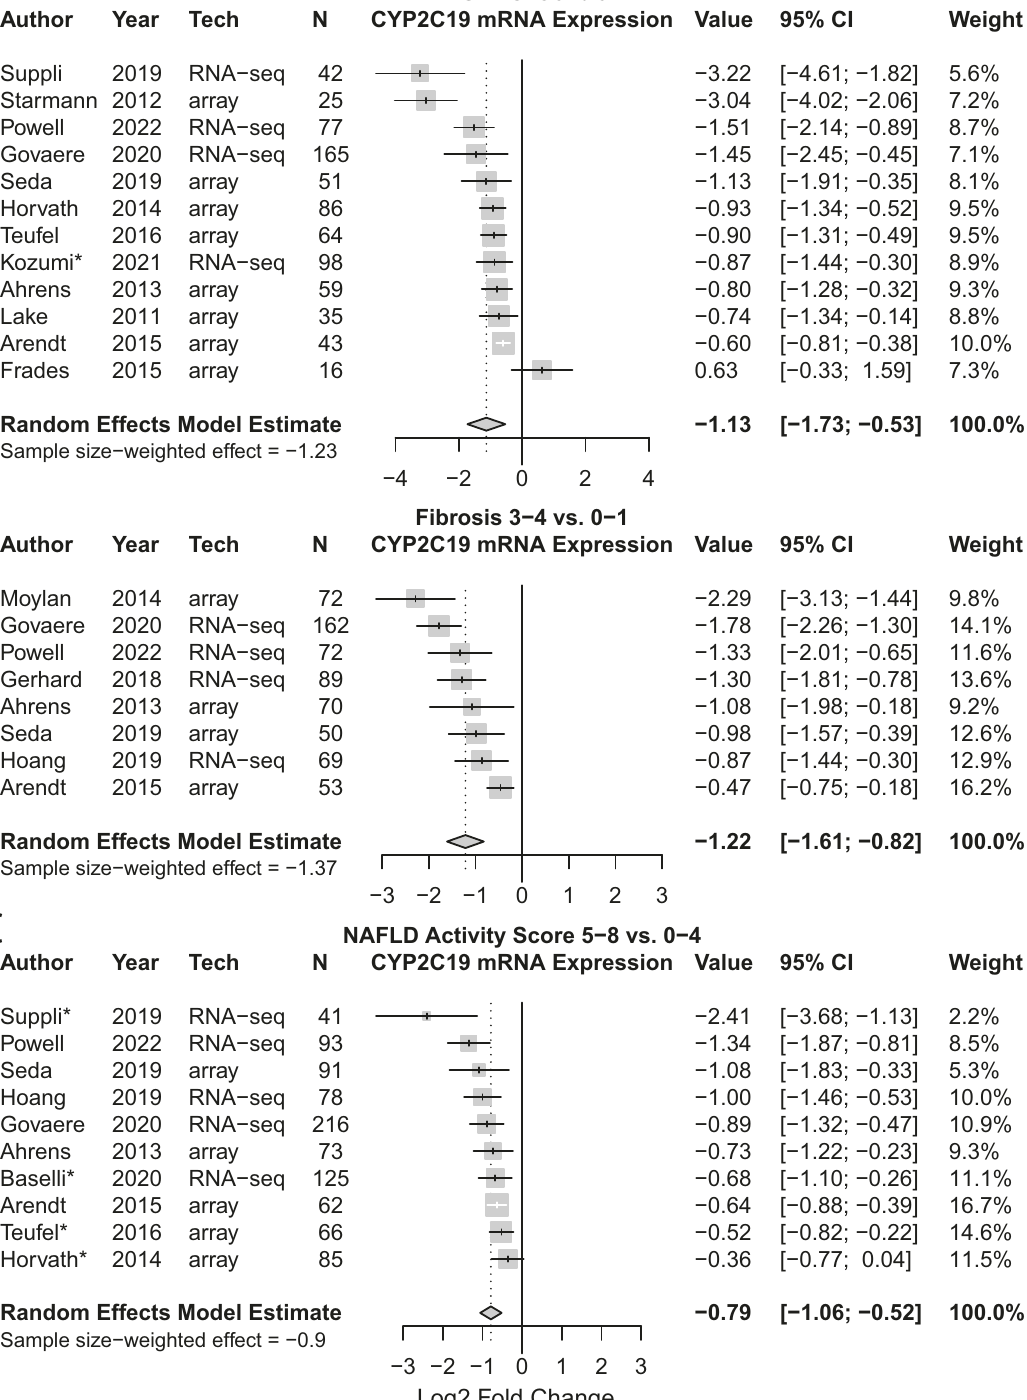
marked with an asterisk (*) NAS was not explicitly given therefore the following analyses are included instead: Suppli et al, Teufel et al, and Horvath et al subjects labelled “ NAFLD ” werecomparedtohealthycontrols,Basellietalsubjectslabelled “ severeNAFLD ” werecomparedto “ mild-noNAFLD ” .Sourcedataforourstudyare provided in the supplemental materials and data from other studies is avail- able in